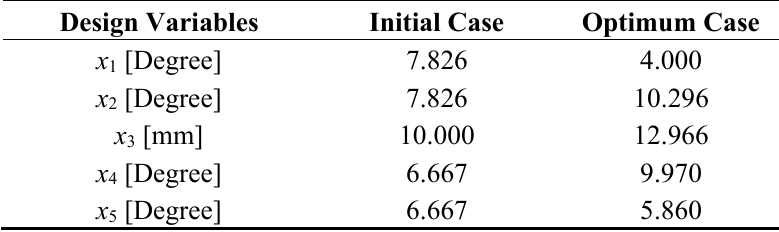
Table 6. Comparison of design variables between initial case and optimum